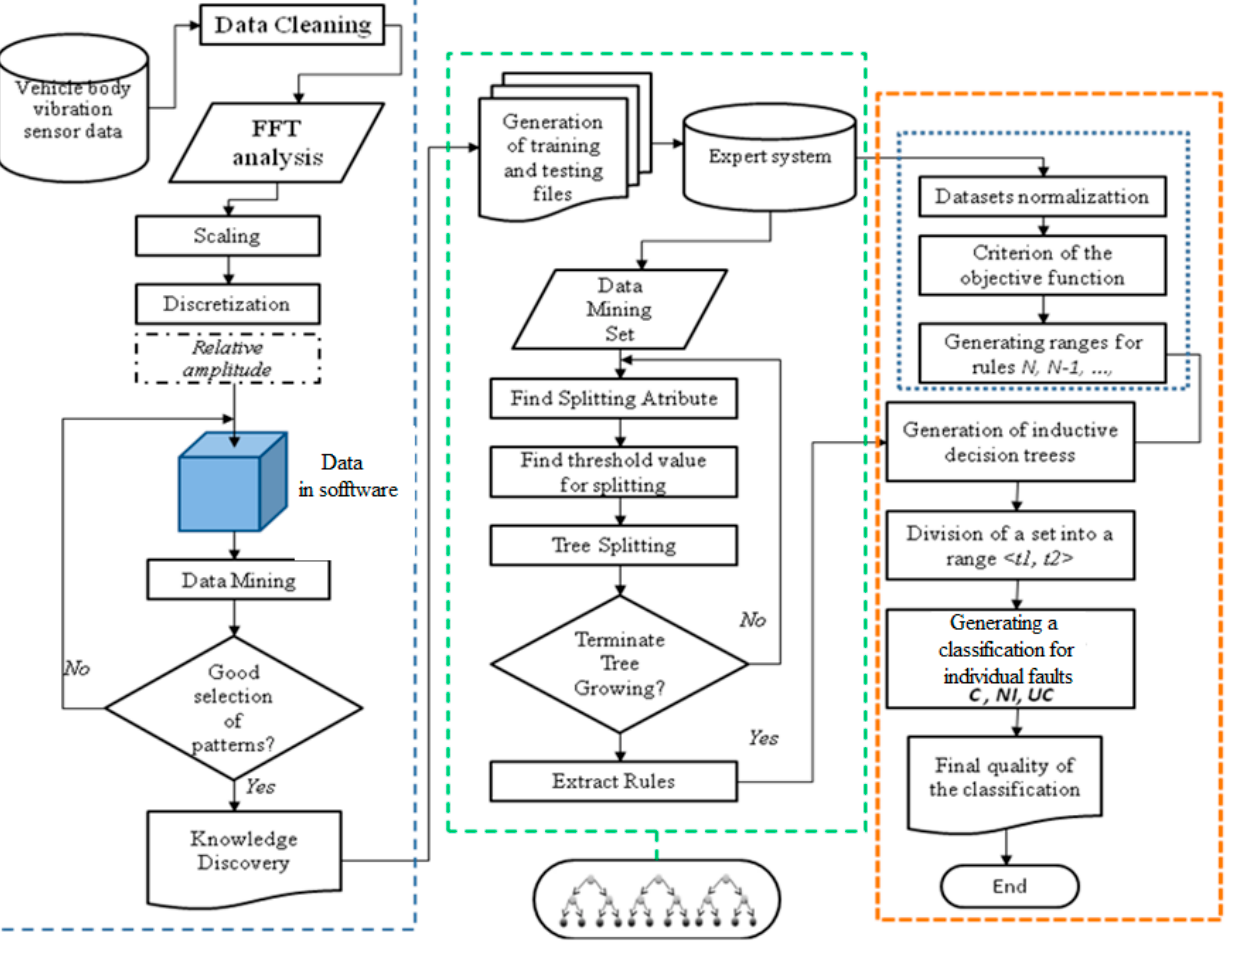
Figure 9. Classification system .